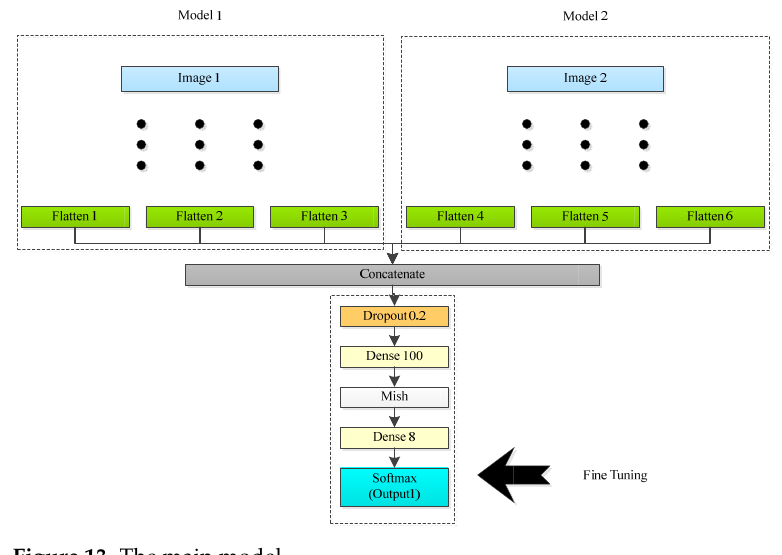
Figure 13. The main model.